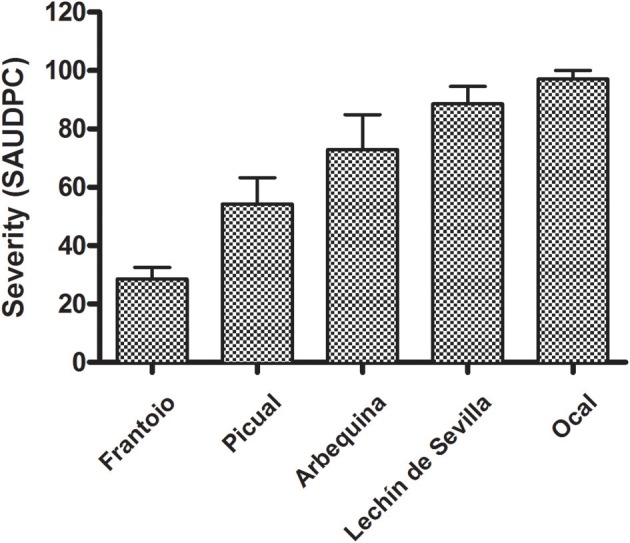
Standard Area Under Disease Progress Curve (SAUDPC) of five reference olive cultivars inoculated with Colletotrichum acutatum. All the cultivars were significantly different according to the Fisher's protected least significant difference (LSD) test at P = 0.05.